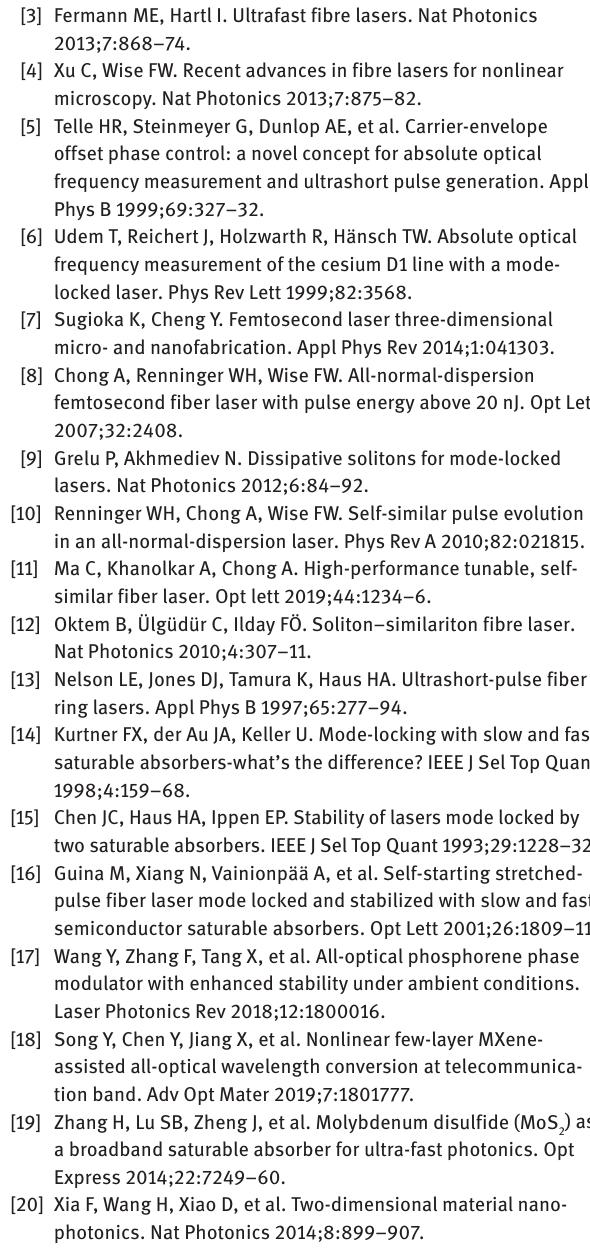
Figure 7: Output performance based on hybrid saturable absorber combines nonlinear polarization evolution (NPE) with V (A) Output power and bandwidth with increase the pump power. (B) Spectrum by increasing